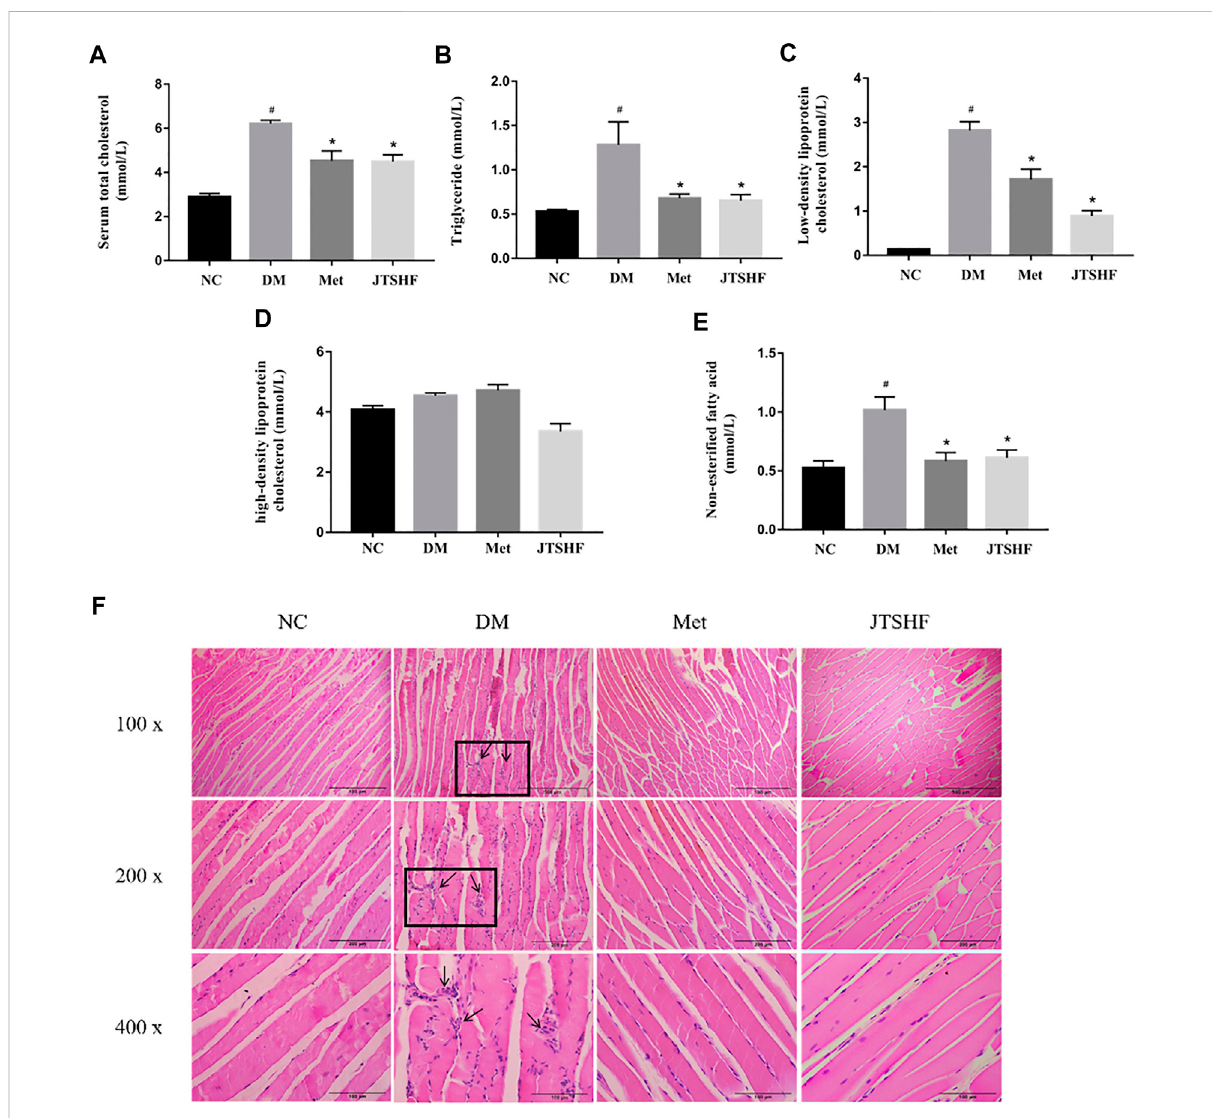
FIGURE 4 JTSHF could improve abnormal lipid pro fi le in HFD-STZ induced diabetic mice. (A) Serum total cholesterol, (B) triglyceride, (C) low-density lipoproteincholesterol, (D) high-densitylipoproteincholesterol, (E) non-esteri fi edfattyacid ofmiceineachgroup. (F) HEstainingofskeletalmuscle tissue (100 x, 200 x, 400 x). All Values were expressed as mean ± SEM. # p < 0.05 versus NC group, * p < 0.05 versus DM group; n = 8 for each group in A –